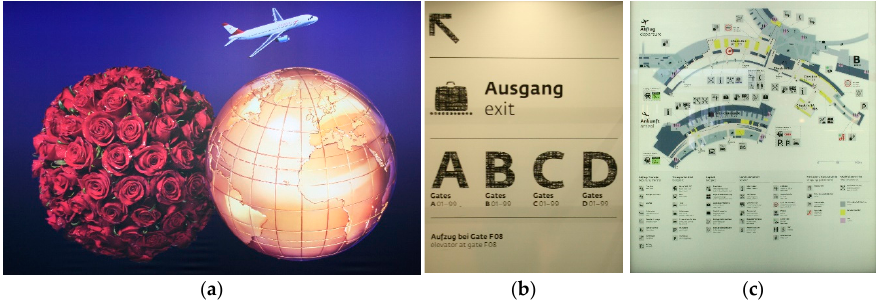
Figure 6. Examples of textured surfaces used as 2D image markers. ( a ) Advertisement; ( b ) Destination board; ( c ) General